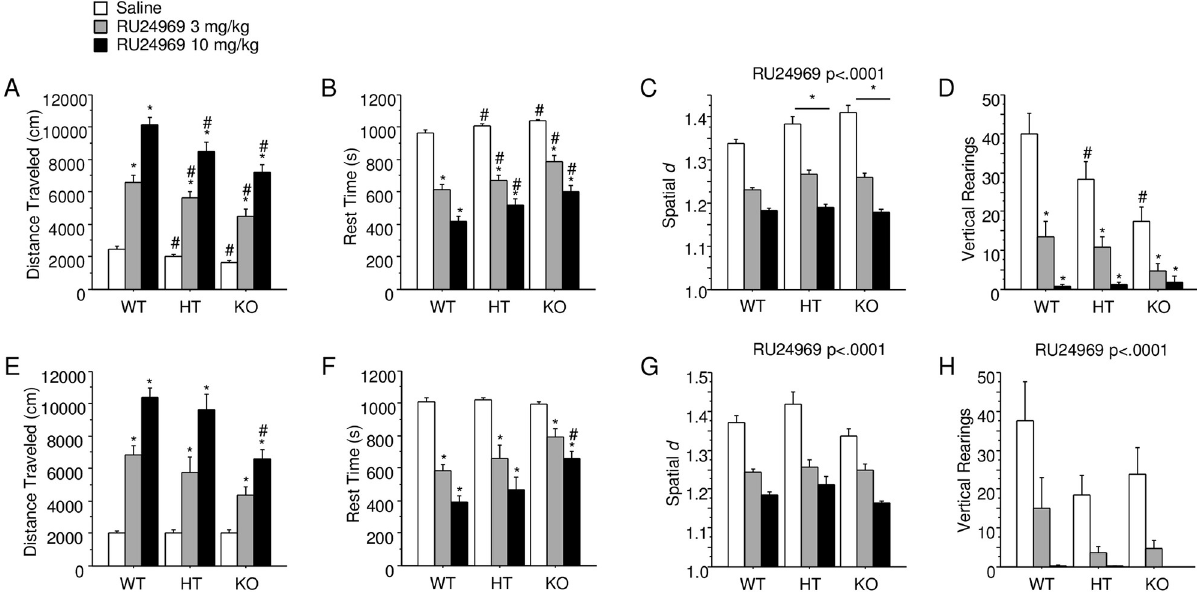
Fig 4. Arrb2 genotype modulates RU24969-induced locomotor effects in the open field test. A—D show raw locomotor data: distance traveled (A), time spent resting (B), spatial d (C), and instances of vertical rearing (D) for all mice from Experiment 5 (n = 13-15/sex/genotype), in which Arrb2 WT, HT, and KO, male and female mice were administered 0 (white bars), 3 (gray bars), or 10 mg/kg (black bars) RU24969 5 minutes prior to initiating behavioral testing. E—H show data corrected for baseline locomotor activity levels in the secondary analysis (n = 4-6/sex/genotype): distance traveled (E), rest time (F), spatial d (G), and instances of vertical rearing (H). Results expressed as mean ± SEM. � Significant difference from saline treatment group within genotype. #Significant difference from WT within treatment condition. � Significant difference from WT collapsed across treatment groups. SEM: standard error of the mean WT: wild-type HT: heterozygous KO: knockout.